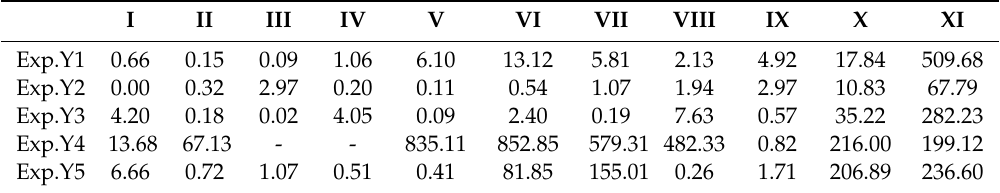
Table 4. Event count rate of each stress stage in Exp.Y1–Exp.Y5. Note: “-” indicates the inexistence of the stage.